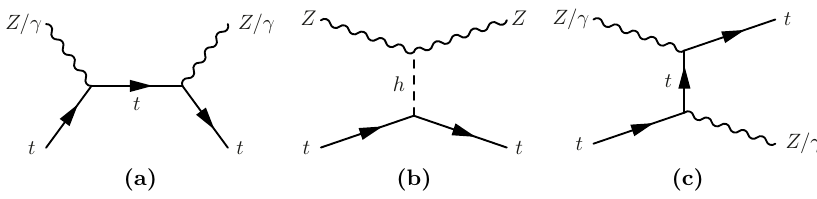
Figure 23. SM diagrams for the tZ